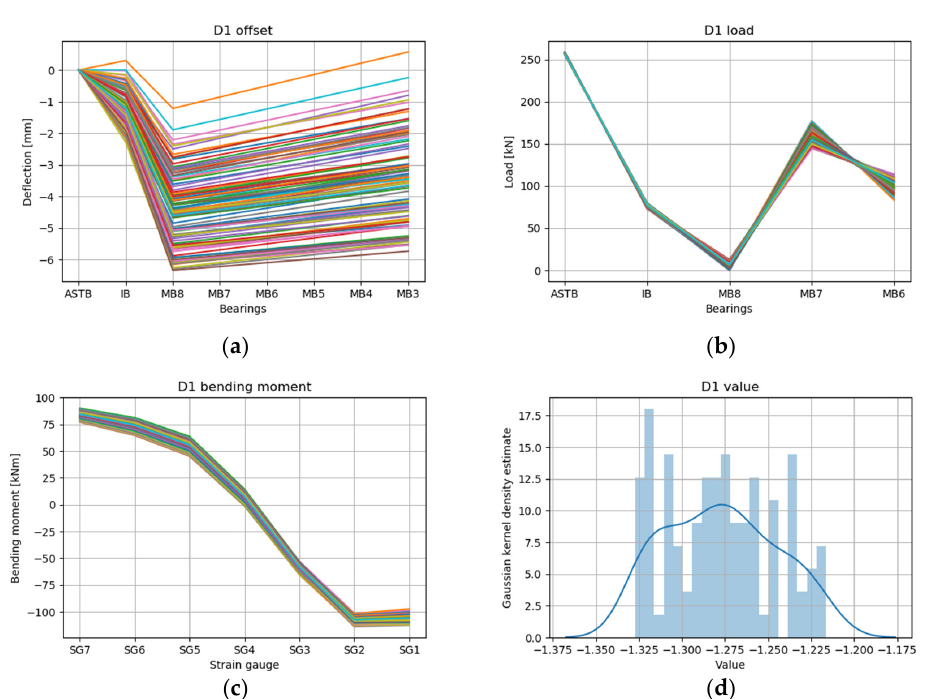
Figure 16. RL results for draft condition D1 top 100 cases: ( a ) offset, ( b ) load, ( c ) bending moment, and ( d ) value.